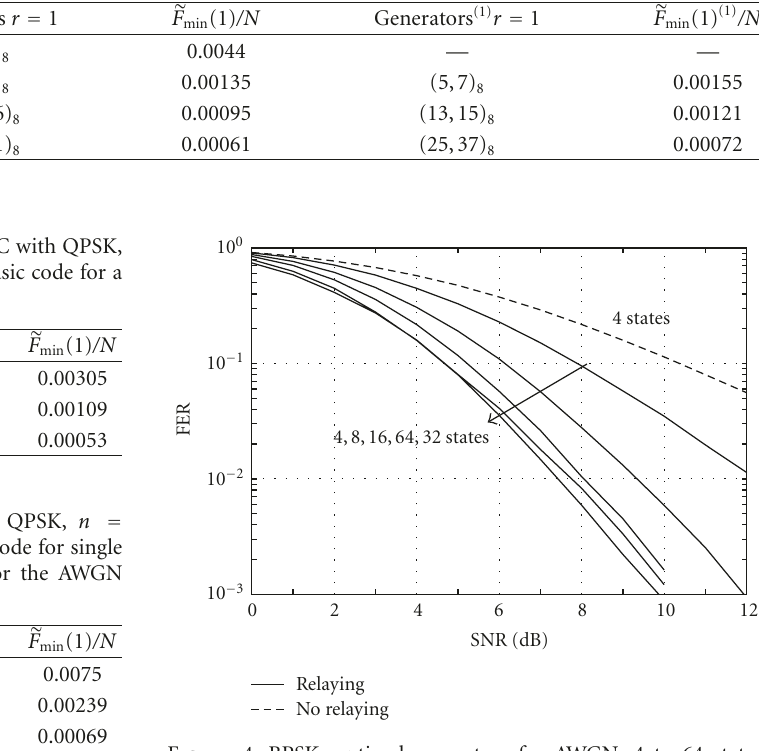
Figure 4: BPSK, optimal generators for AWGN, 4 to 64 states, 2 relays, 2 transmitting antennas per node, 1 receiving antenna, quasistatic fading channel L = 1.